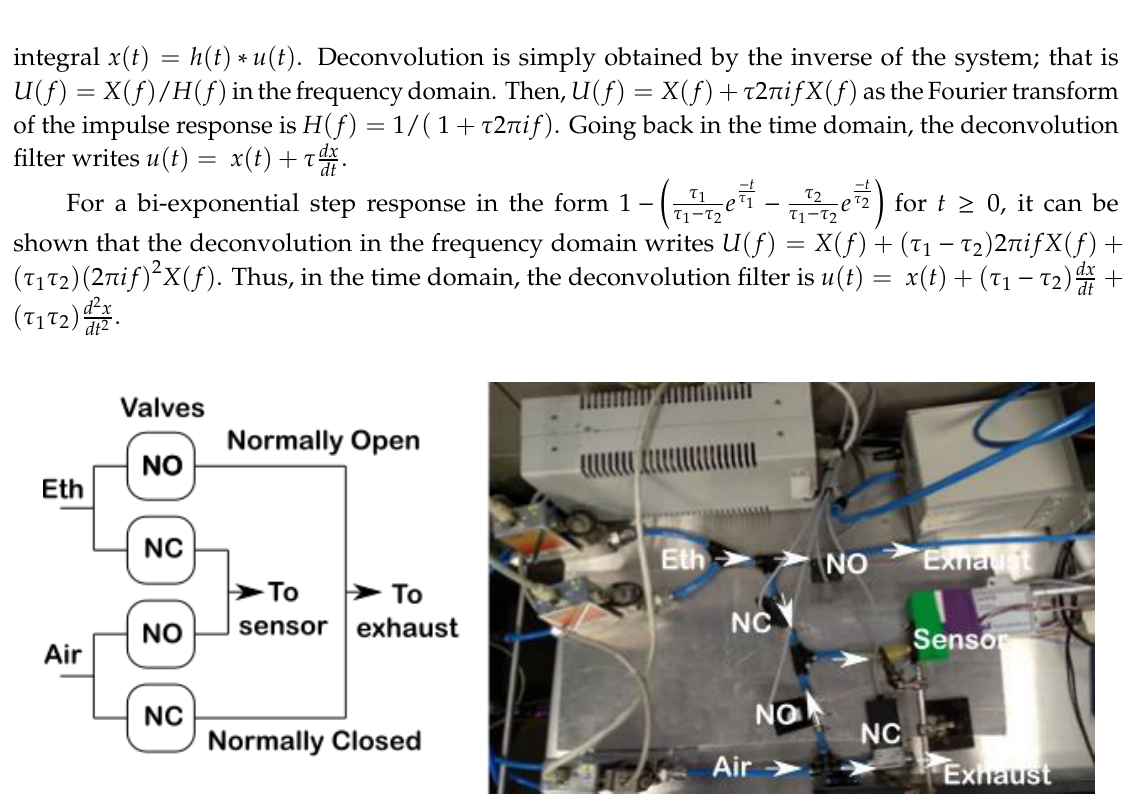
Figure A1. Test bench used in the step experiments. The electrovalves are two-way: normally open (NO) or normally closed (NC). See text in Appendix A for details.